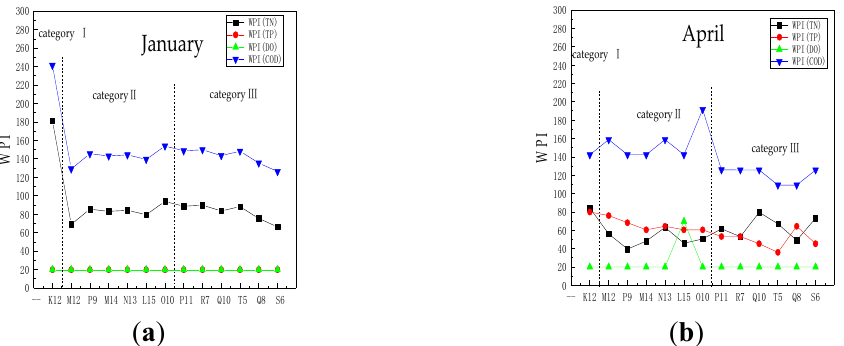
Figure 10. Spatial variation in WPI in 13 sampling sites in the dry season: ( a ) January; ( b ) April.